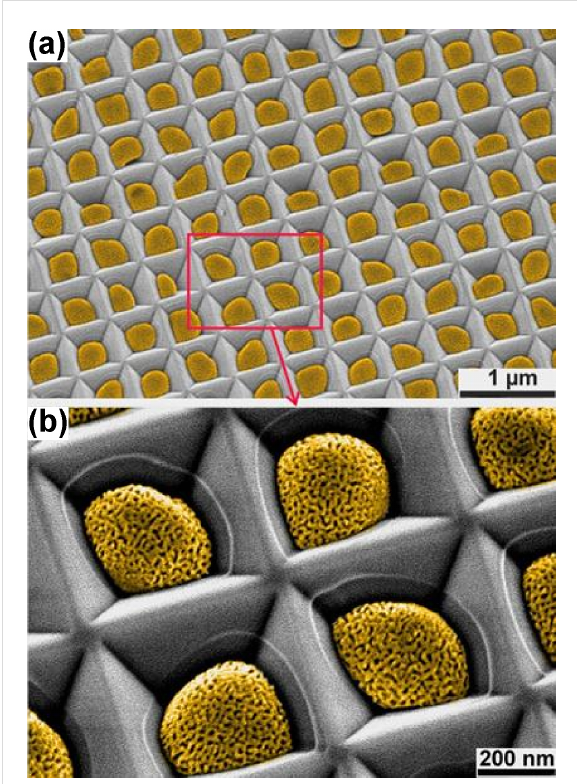
Figure 3: SEM images (false color) at 25° tilt of the perfectly ordered array of the nanoporous gold nanoparticles formed from the 15 nm Au/30 nm Ag